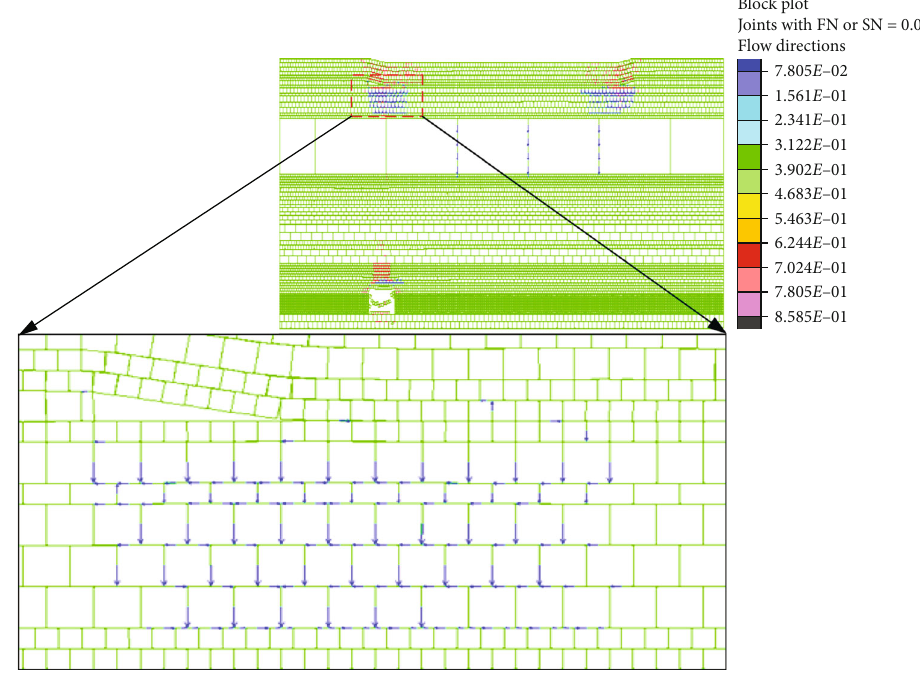
Figure 5: The fl ow velocity vector distribution in initial caving of direct roof.